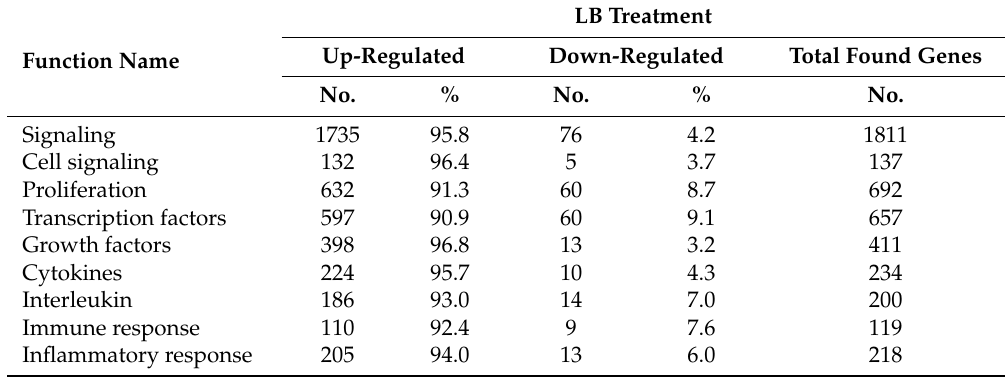
Table 1. Functional classification of differentially expressed genes under lactobacilli mixture treatment.